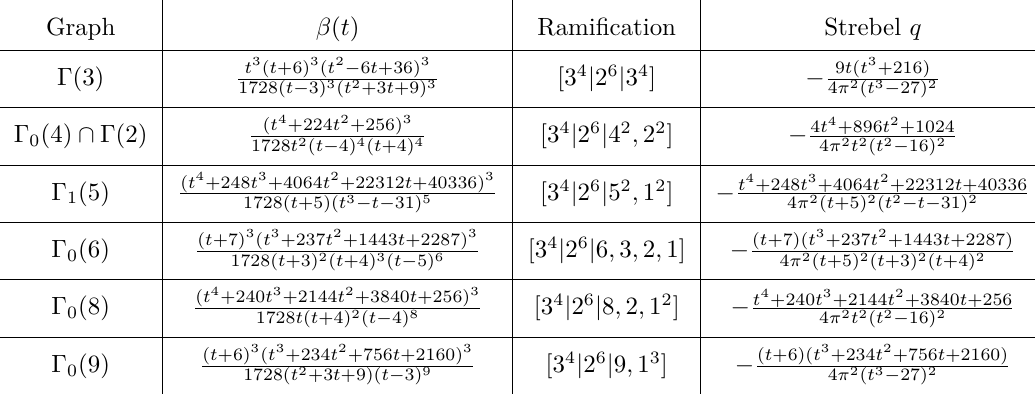
Table 1. The list of the six genus-zero, torsion-free, congruence subgroups of the modular group Γ , of index 12. The corresponding Belyi maps β ( t ) and their ramification indices, as well as the Strebel differentials are also shown. Note that the ramification indices for all 6 are such that there are 4 pre-images of 0 of order 3 and 6 pre-images of 1 of order 2. The pre-images of ∞ (aka the cusp widths ) all add to 12, as do the ramification indices for 0 and 1. This is required by the fact that all the subgroups are of index 12 within Γ